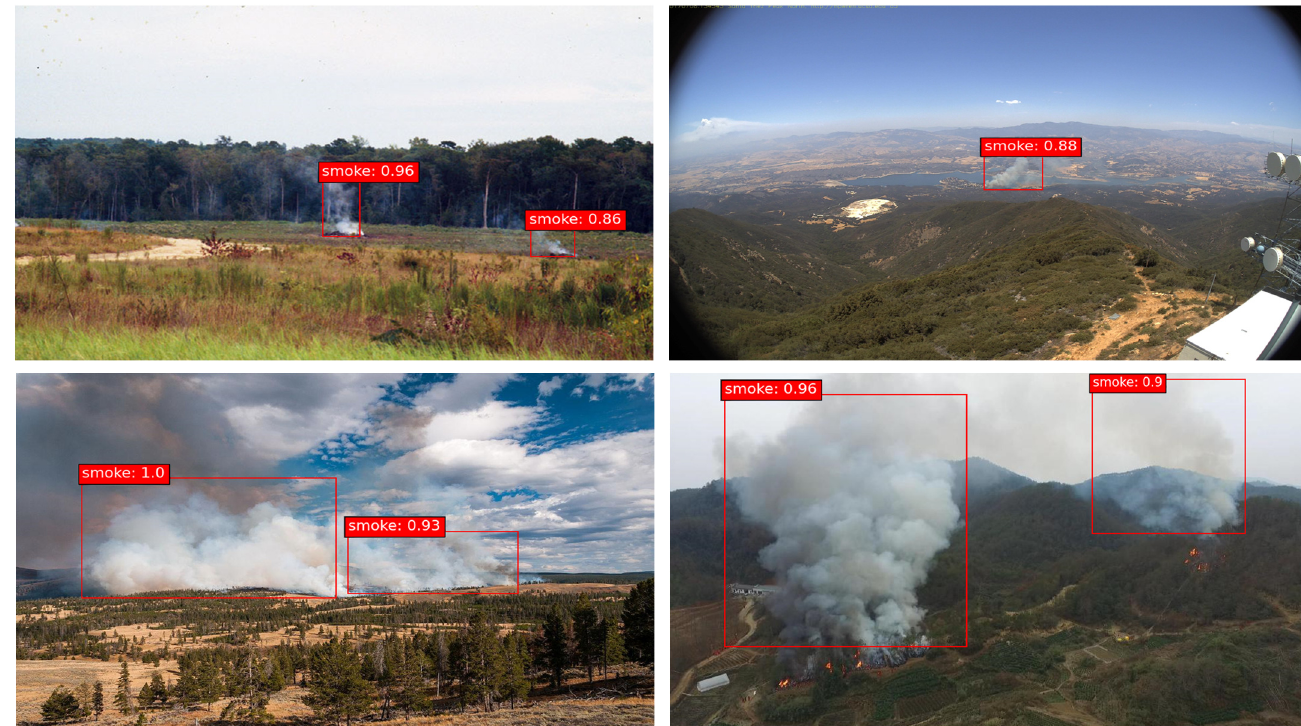
Figure 7. Detection results of our improved deformable DETR model. The first row shows small- target smoke images, the second row shows large-target smoke images.